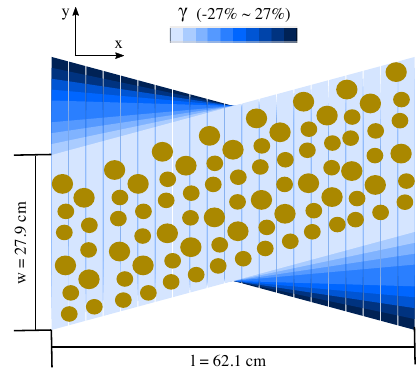
Figure 1. Schematic of special apparatus for applying simple shear strain to a collection of photoelastic discs at the beginning (left) and the end (right) of shear. In the sketch, both the slats and particles are drawn much larger relative to the boundaries than in the real experiment. The x − y axes indicate the coordinate system in the lab frame, where simple shear is applied along the y axis.